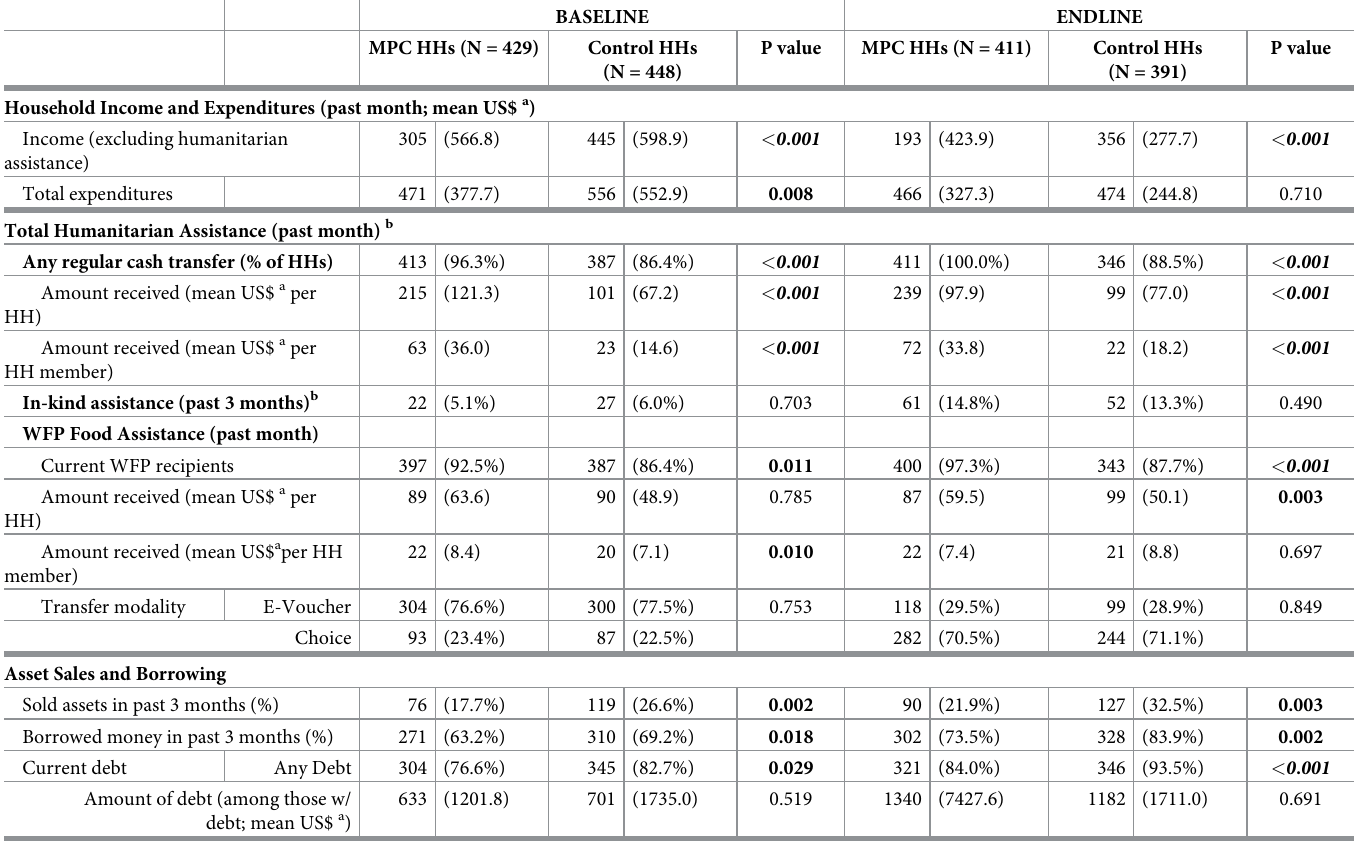
Table 3. Household economy and receipt of humanitarian